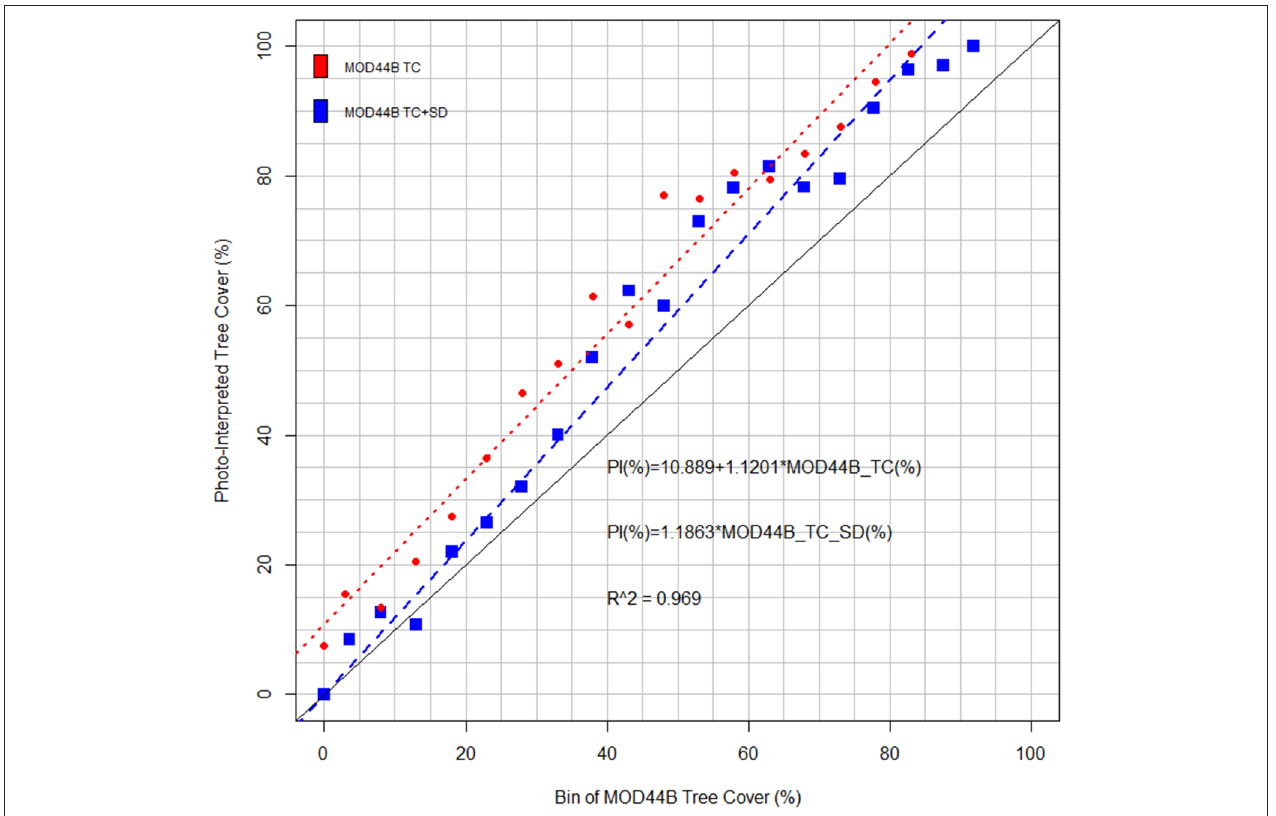
FIGURE 1 | Regression between photo-interpreted (PI) tree cover (%) and two forms of MOD44B tree cover, with (blue dashed line) and without (red dotted line) standard deviation (%), across 5% intervals. Each data label indicates the number of megacities sampled in the PI analysis.